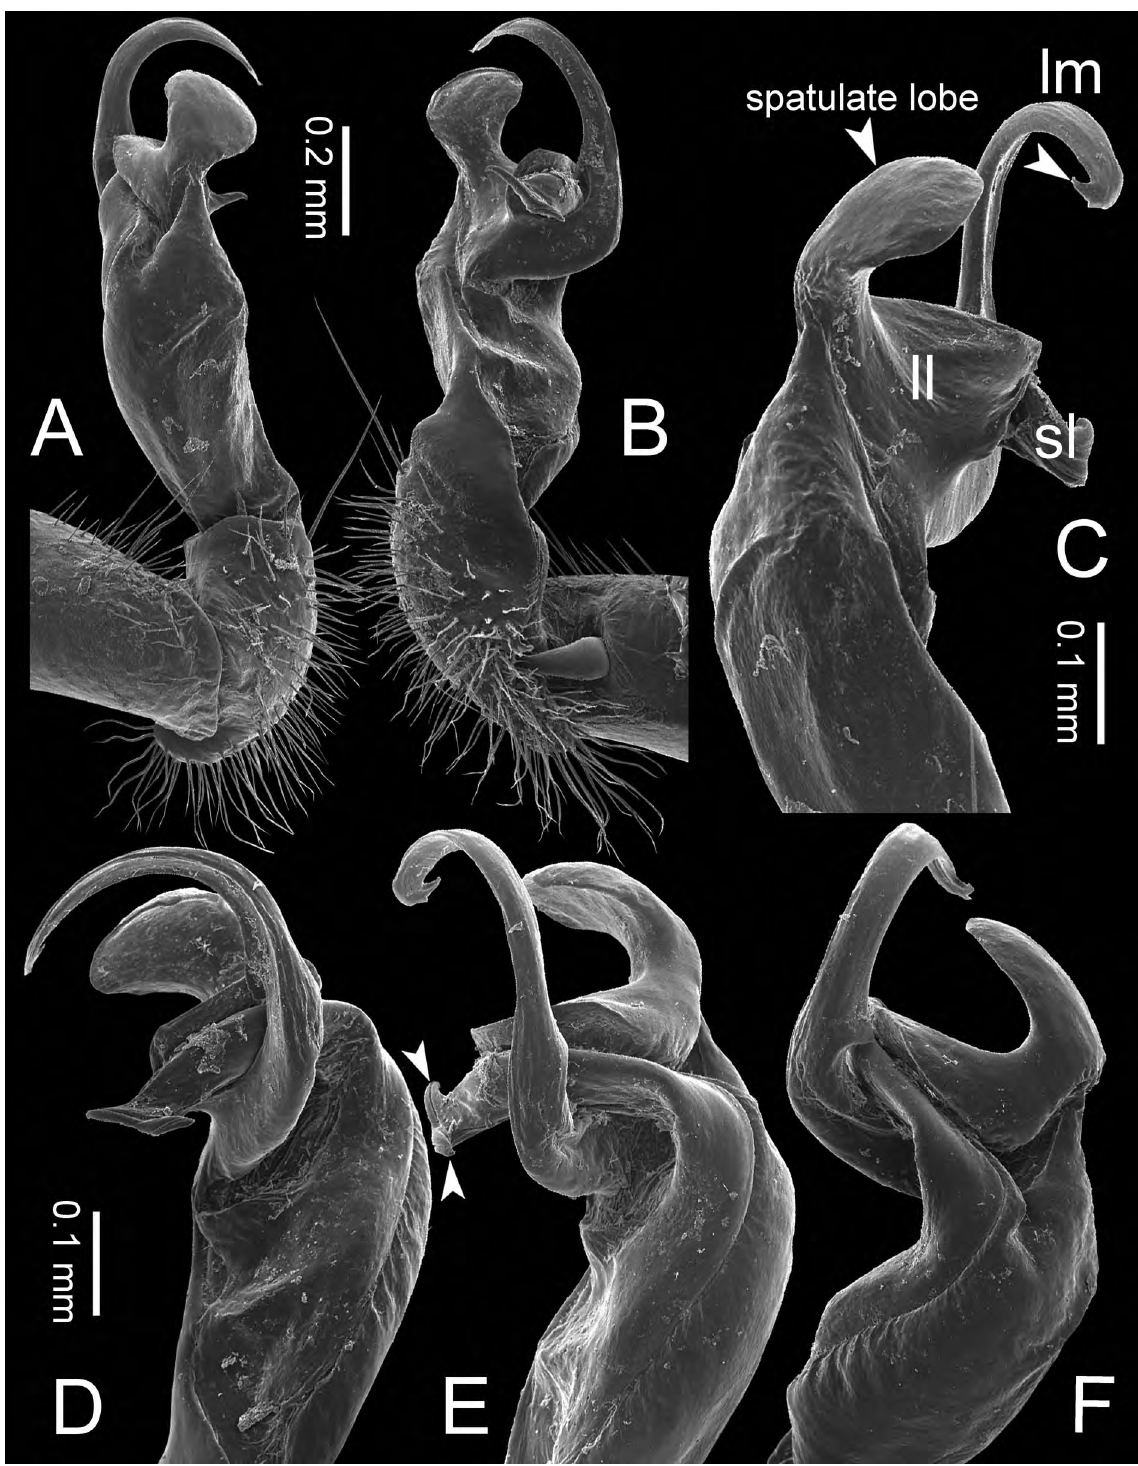
Fig. 26. Nagaxytes spatula Srisonchai, Enghoff & Panha gen. et sp. nov., paratype (CUMZ- pxDGT00121), right gonopod. A . Lateral view. B . Mesal view. C . Ventral view (arrowhead = hook-like tip). D , F . Subdorsal view. E . Dorsal view (arrowheads = tip of solenomere terminating in two curved